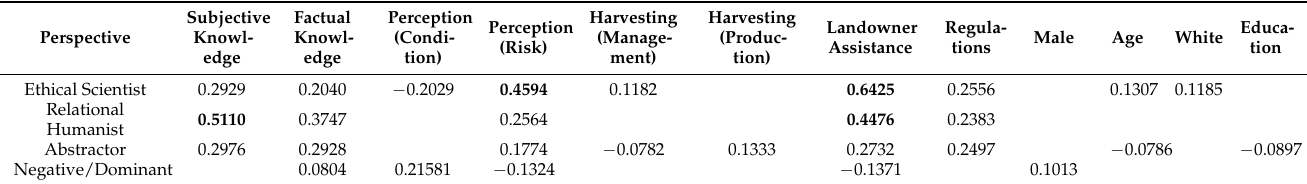
Table 8. Spearman’s rank correlation test between perspectives and designated cognitive parameters ( n = 656).